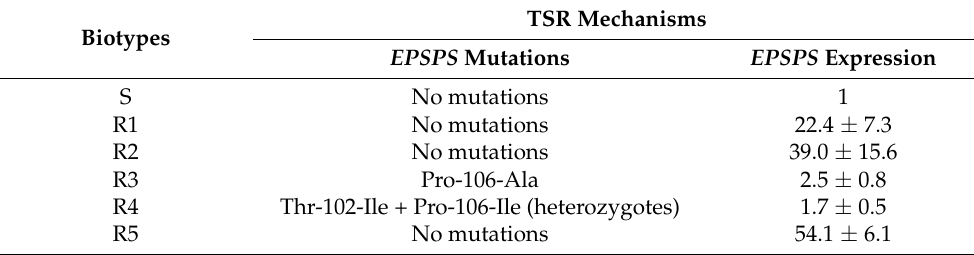
Table 2. EPSPS genotypes and expression levels in the S and R